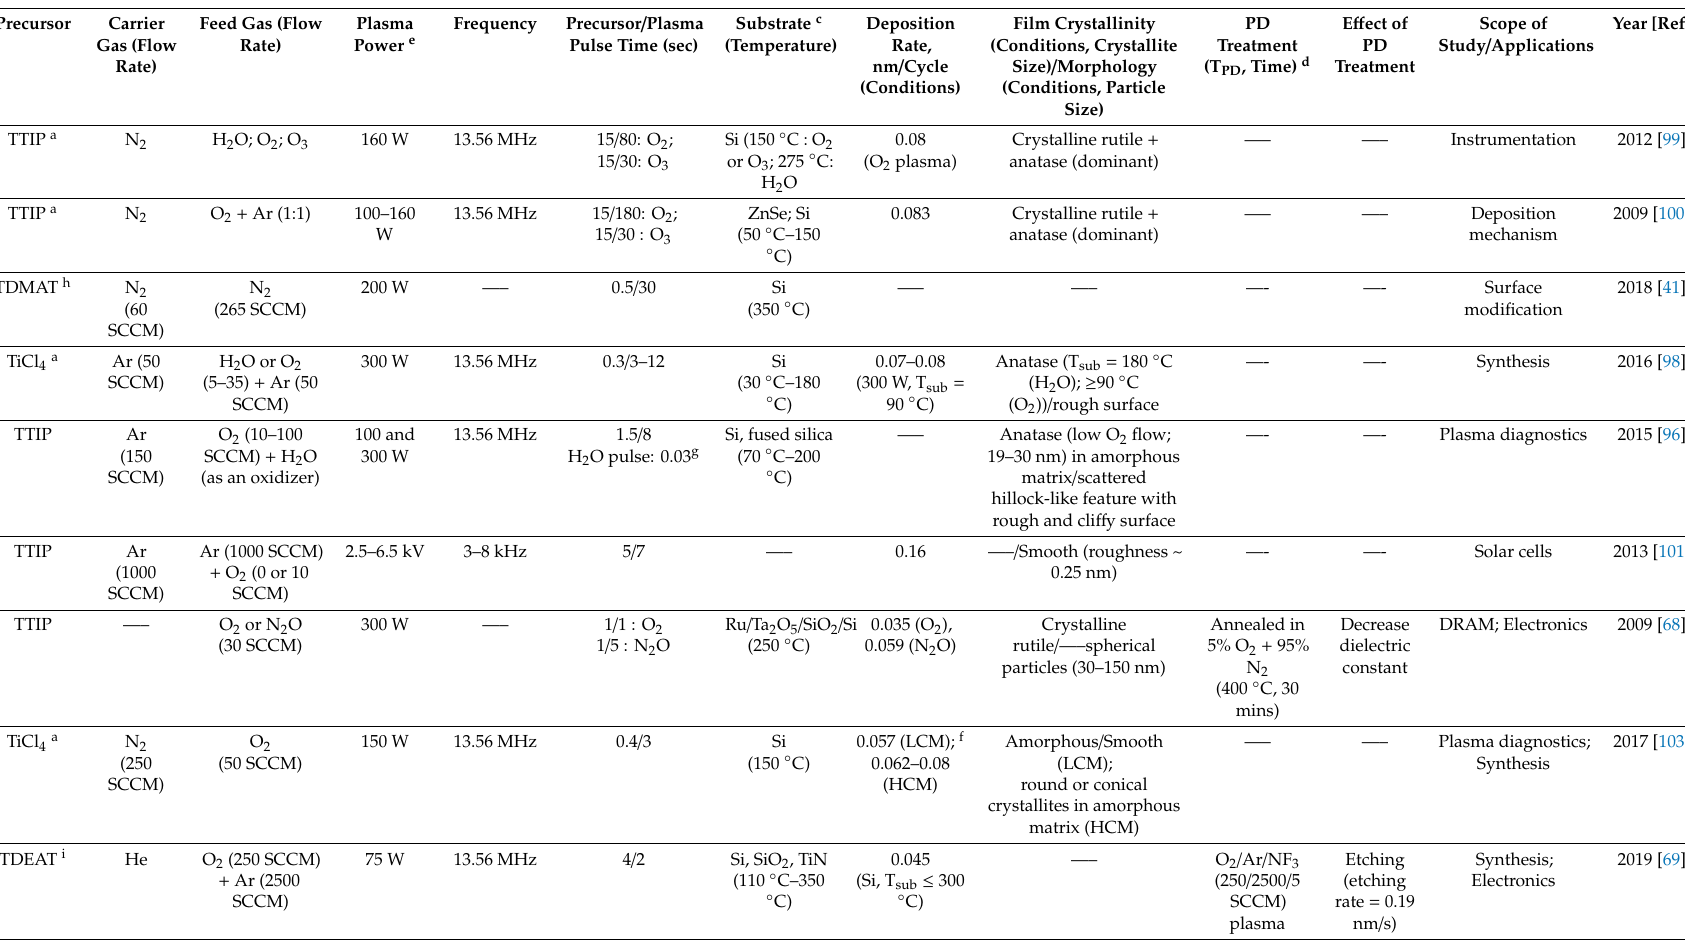
Table 2. Summary of deposition and plasma parameters, post-deposition treatment conditions, and their e ff ects on TiO 2 film morphology for PEALD. Studies are ordered in terms of decreasing plasma pulse time used in each